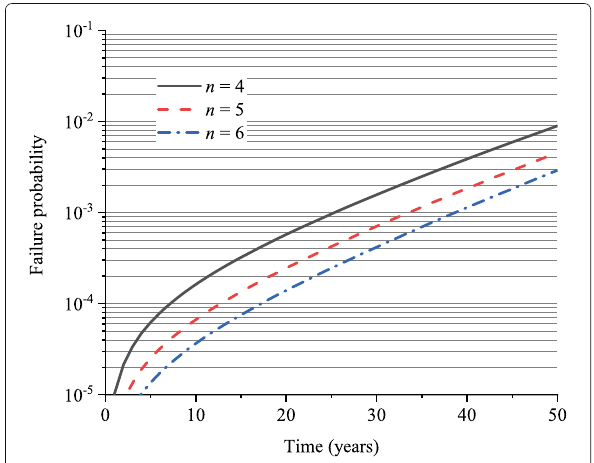
Fig. 4 Time-dependent failure probabilities of 3-out-of- n systems for different numbers of component